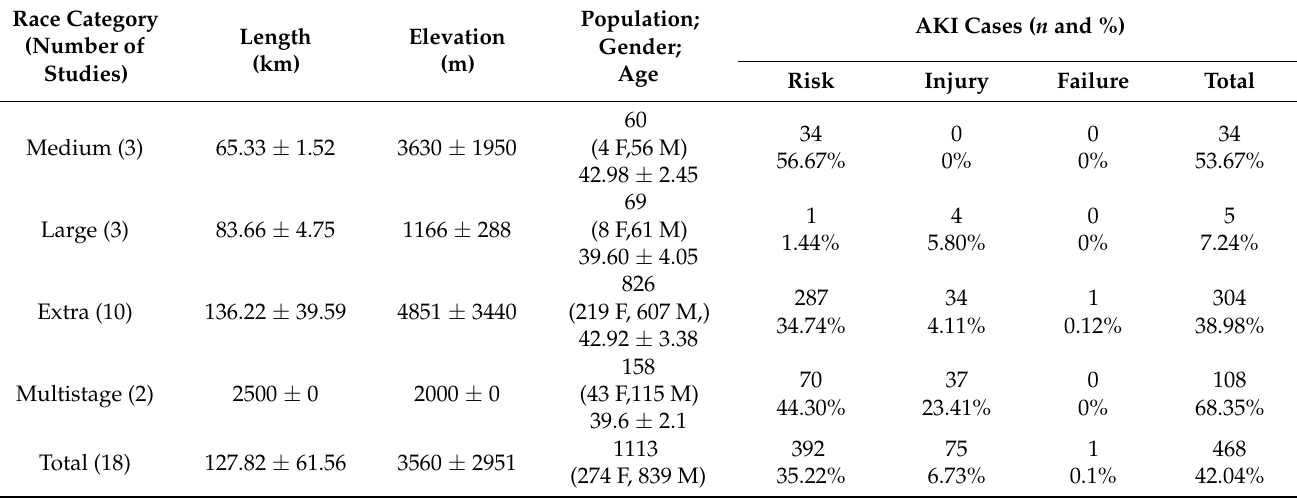
Table 3. AKI cases sorted by race category.